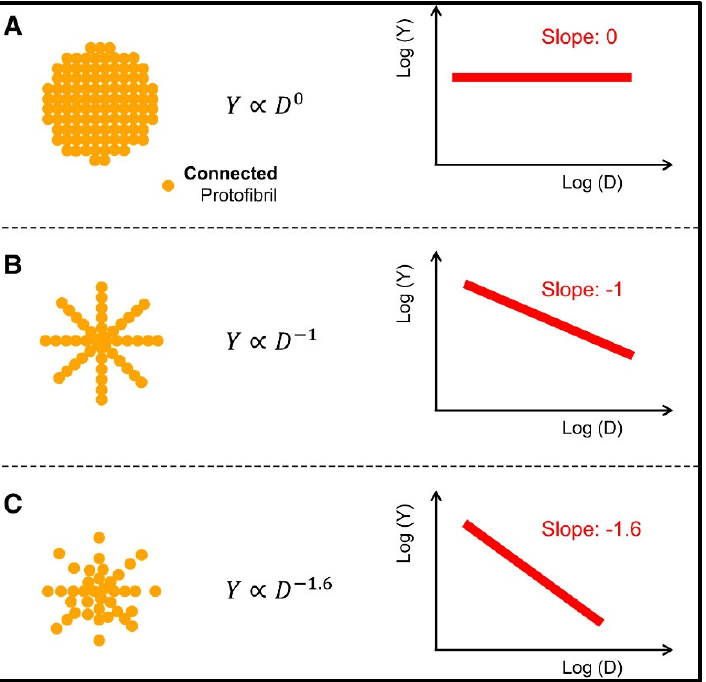
Figure 11. Cross-section fibrin fiber models and their corresponding stretch modulus. ( A ) A fiber with uniformly connected protofibrils has a stretch modulus that is independent of diameter, D. ( B ) A fiber with a bicycle-spokes-like cross-section can have a stretch modulus that decreases as D −1 . ( C ) Based on experimental observations, however, the stretch modulus scales as D −1.6 . This may indicate that the density of connected protofibrils will decrease with increasing fibrin diameter, D, as D −1.6 . Reprinted/adapted with permission from Ref. [160]. 2021, Elsevier.